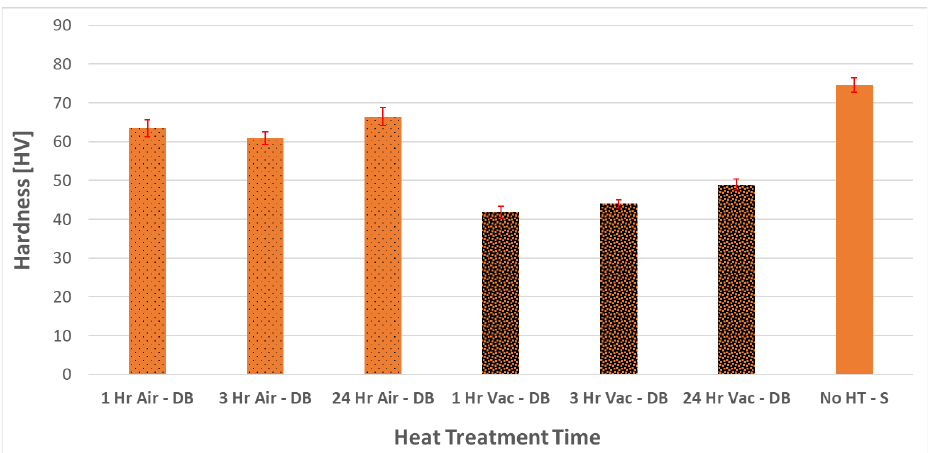
Figure A1. AA1050 hardness before and after DB process.